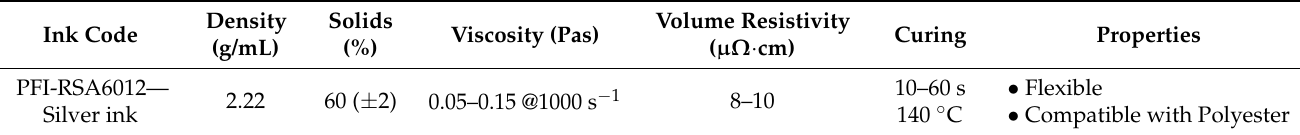
Table 3. PFI-RSA6012—Silver ink